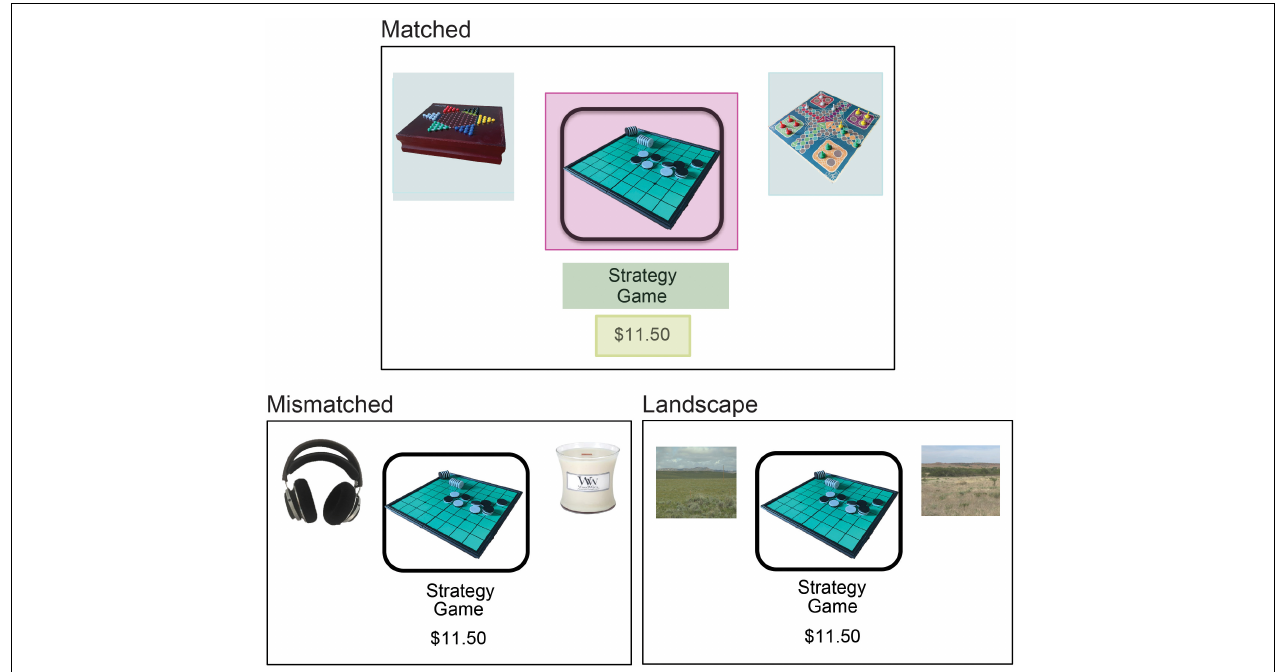
FIGURE 1 | Study 1 sample presentation stimuli. Shaded areas in the Matched condition illustrate the nature of AOI placement for the target image, display images, target label, and target price. Images are for illustration purposes only. See experimental materials for exact